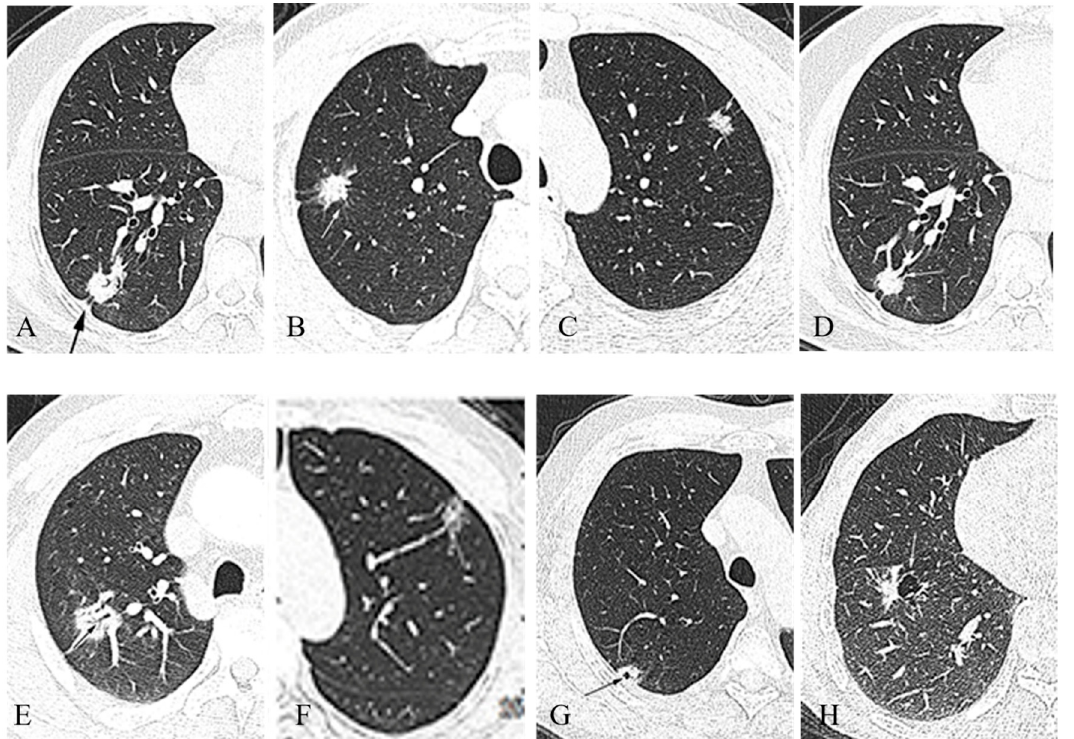
Figure 1. Display of common malignant signs: ( A ) pleura traction sign (black arrow); ( B ) spicule sign (white arrow); ( C ) lobulation sign; ( D ) bronchial cutoff sign; ( E ) air bronchogram sign (black arrow); ( F ) tumor vasculature sign; ( G ) vacuole Sign (black arrow); ( H ) cavity sign (white arrow).